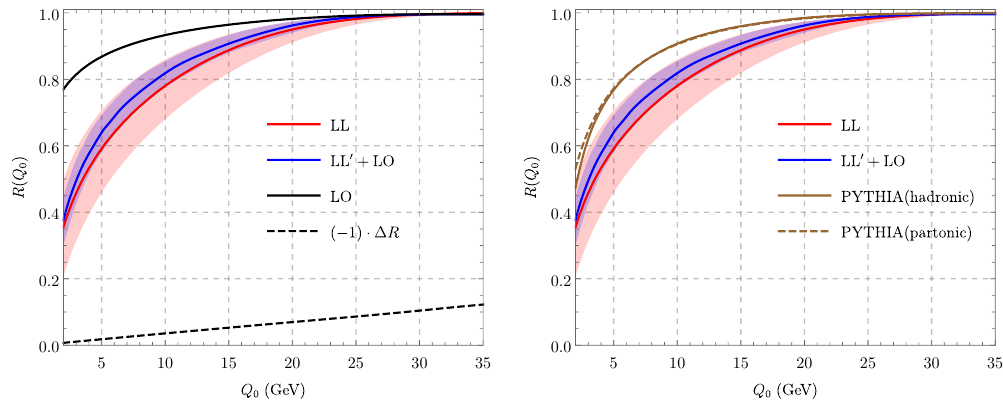
Figure 7 . Comparison of our results for the interjet energy (cid:13)ow to (cid:12)xed order (left plot) and to PYTHIA (right